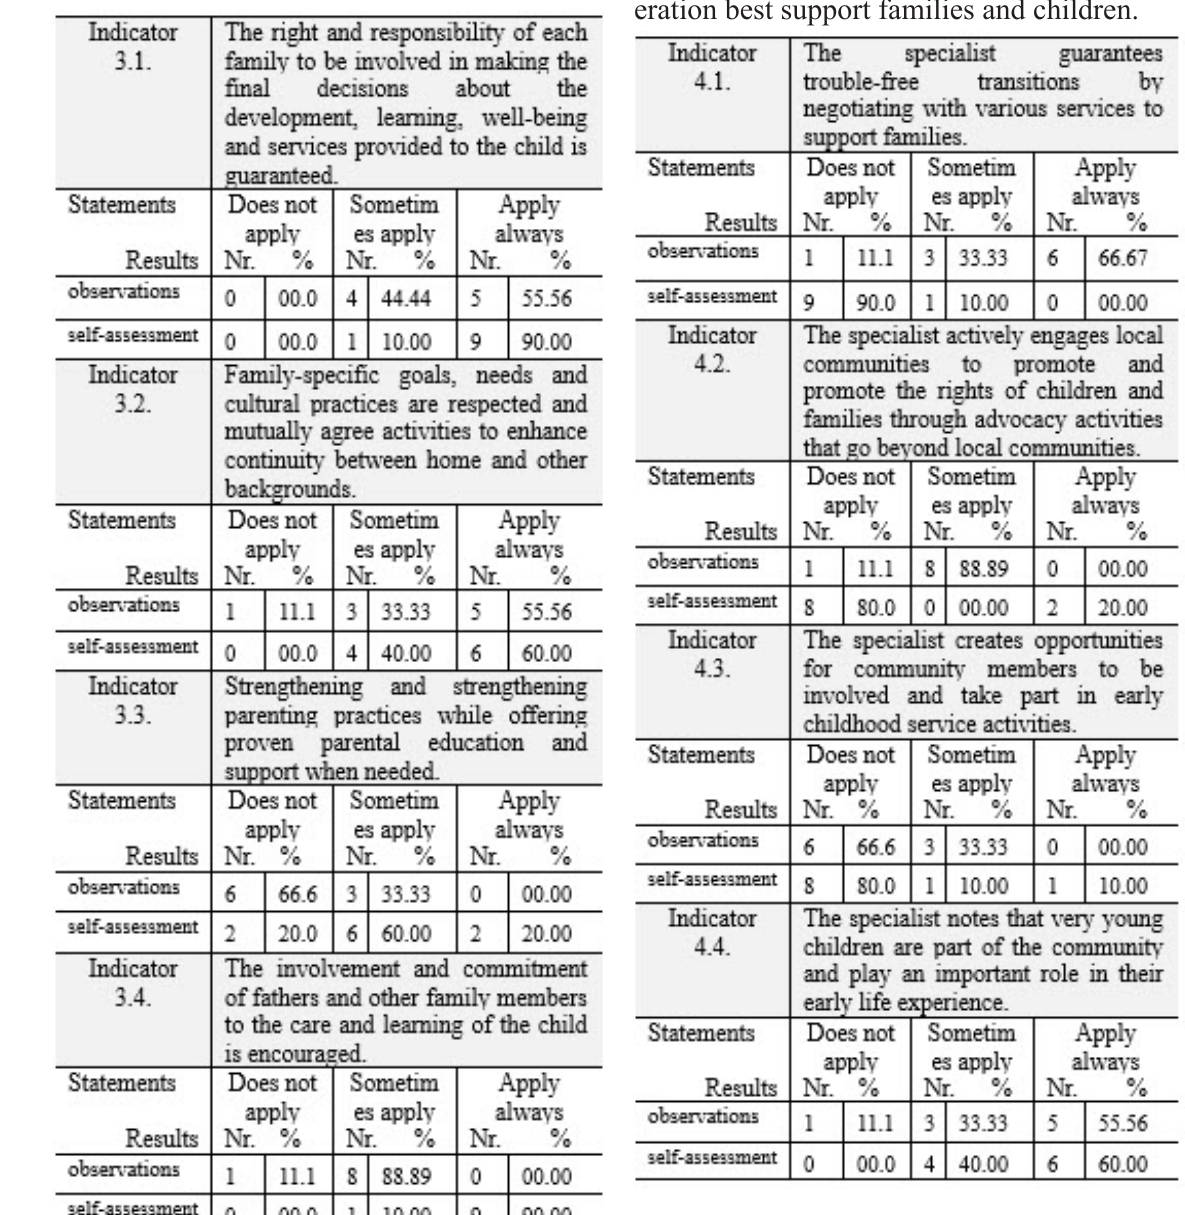
Table 8. Principle 3: Services are best provided in partnership with the family.